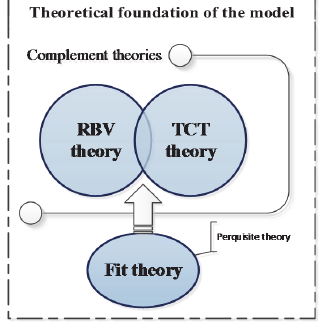
Fig. 3. Theoretical foundation of the